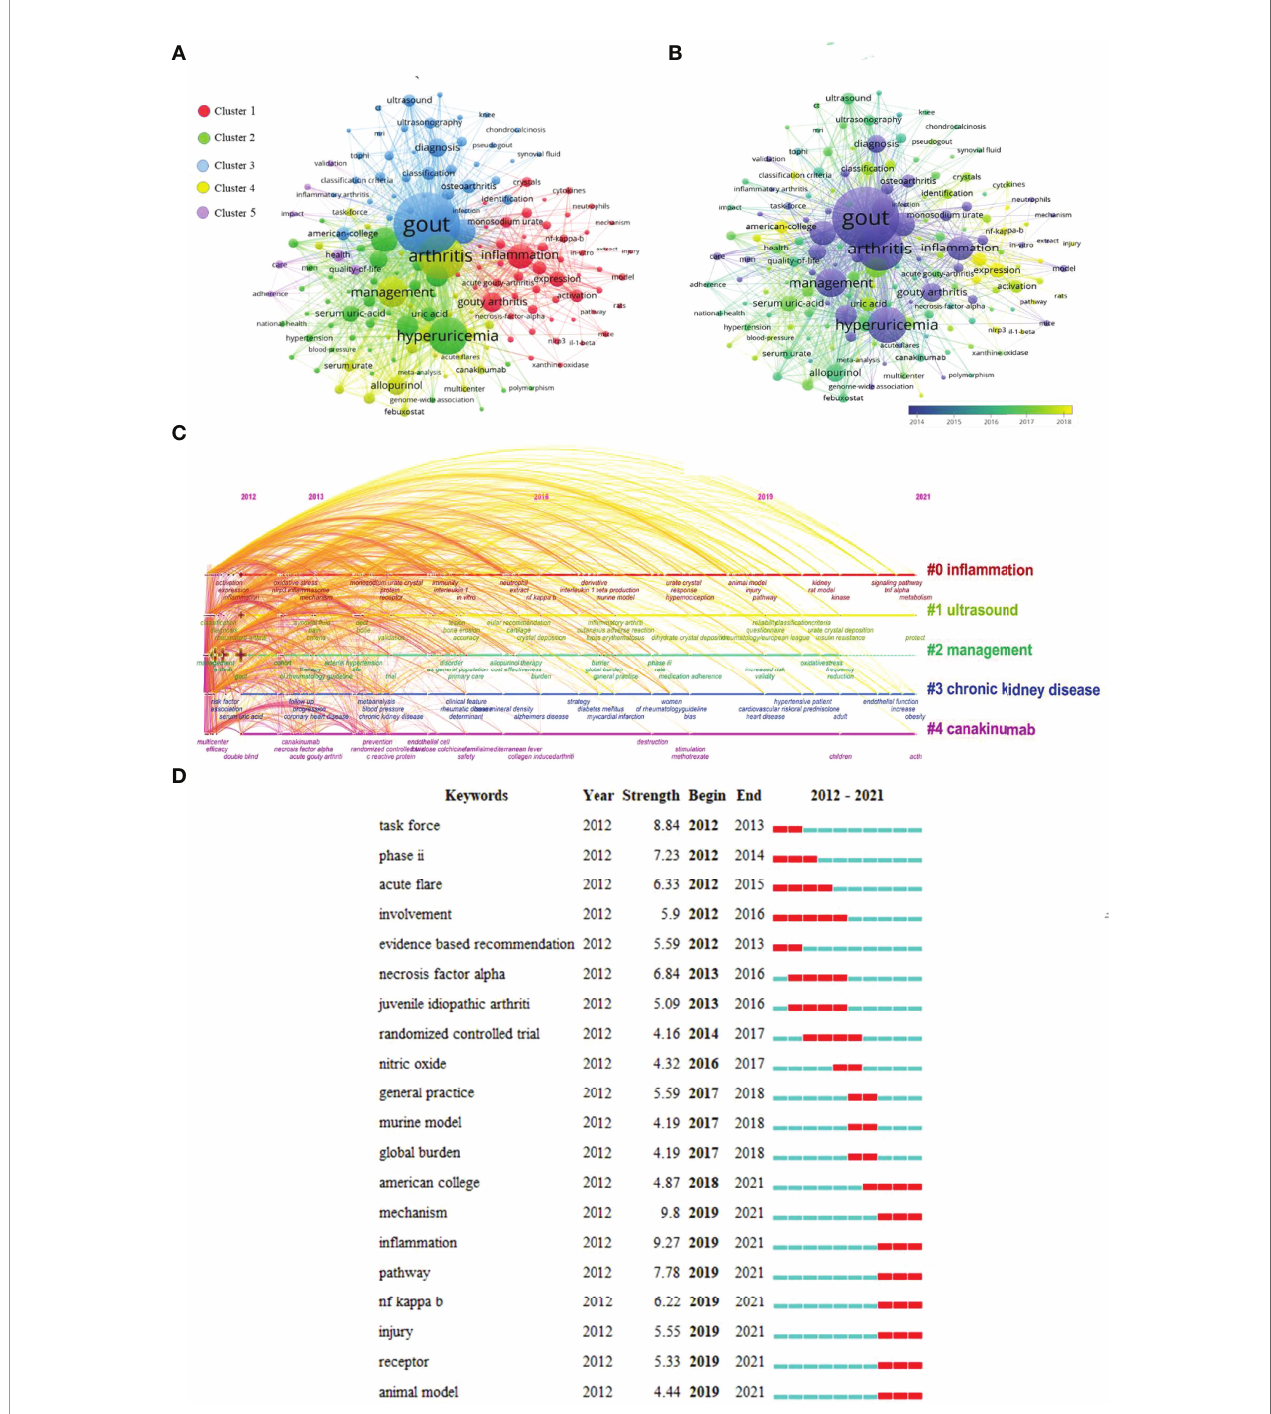
FIGURE 8 | GA ’ s keyword mapping. (A) Using different colours, the 168 terms that appeared more than 20 times were separated into fi ve clusters: Cluster 1 (red): the in fl ammatory mechanism of GA. Cluster 2 (green): the prognosis, and epidemiology of GA. Cluster 3 (blue): the research on the diagnosis of GA. Cluster 4 (yellow): the clinical research of GA. Cluster 5 (purple): the care and risk factors for GA. The size of the nodes indicates occurrence frequency. (B) Keyword visualization according to the APY. The different colours indicate the relevant year of publication. Yellow keywords came later than purple keywords. (C) Timeline distribution of keyword cluster analysis. (D) The top twenty keywords with the most bursts. The years between “ Begin ” and “ End ” represent the period when the keyword was more in fl uential. Years in light green mean that the keyword has not yet appeared, years in dark green mean that the keyword is less in fl uential, and years in red mean that the keyword is more in fl